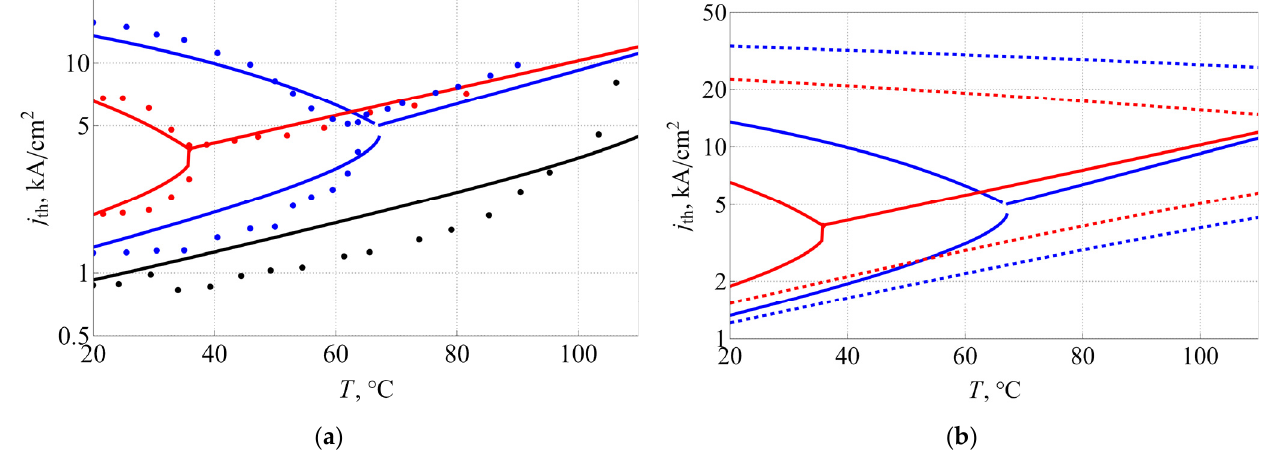
Figure 4. Temperature evolution of the threshold current densities of GS (lower curve until inter- section point) and ES (higher curve if present) lasing for microdisks of different diameters (28 μ m: black, 24 μ m: blue, 20 μ m: red). Solid lines denote calculation; dots denote the experimental data ( a ); comparison of the temperature dependences of threshold current densities calculated with (solid lines) and without (dotted lines), taking into account free carrier absorption dependency on reservoir population, as described by Equation (6) ( b ). Colors denote data for microdisks of different diameters (24 μ m: blue, 20 μ m: red).